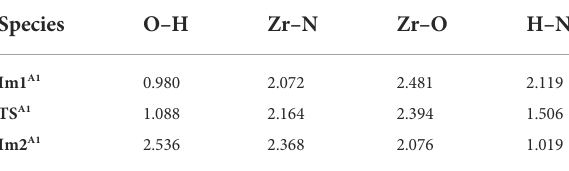
TABLE1Bondlengths(Å)atthereactioncenterintheA1sectionofthe TDMAZ reaction on the hydroxylated